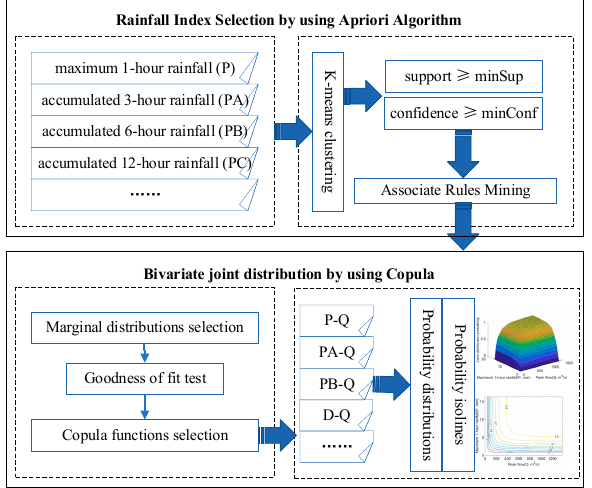
Figure 2. Flow-chart of the methodology.